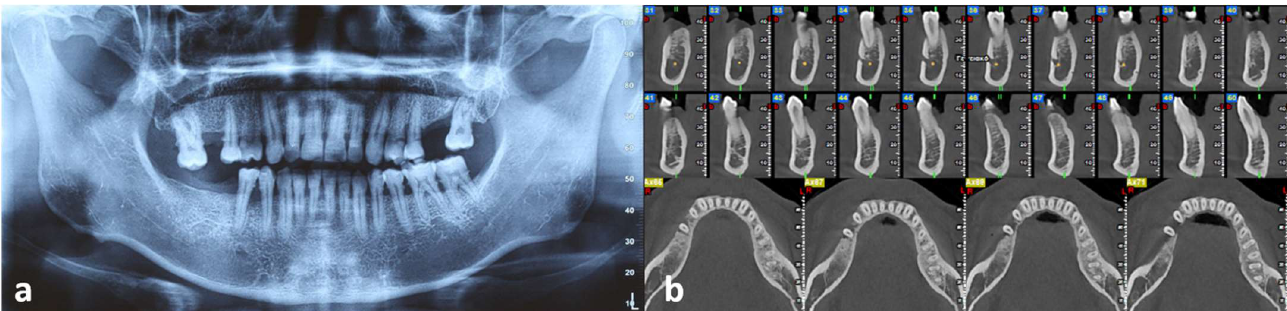
Figure 2. ( a ) Panoramic radiograph showing alveolar bone loss in proximity to the right mandibular premolar area. ( b ) Cross-sectional and axial views of cone-beam computed tomography (CBCT) revealing superficial resorption of the alveolar ridge and destruction of the buccal cortical bone in the area of the right mandibular premolars.